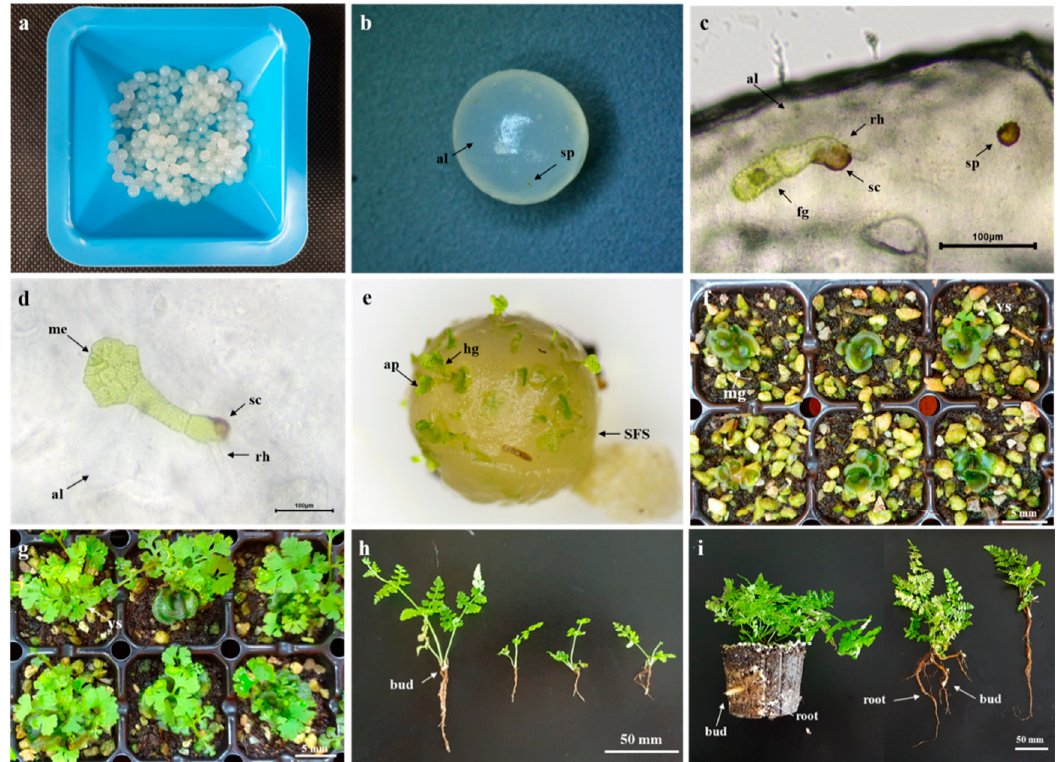
Figure 3. SFS (synthetic seeds using fern spores) production and growth cycle of bracken through spore-derived encapsulation method: ( a ) SFS produced with a 2.5 mm syringe tip; ( b ) spores inserted into the alginate matrix; ( c ) germinated spore and gametophyte after two day in SFS; ( d ), normal developing gametophyte; ( e ) heart-shaped gametophytes formed on the inside and surface of SFS; ( f ) mature gametophytes and young sporophytes developed after 4 weeks in SFS; ( g ) young sporophytes grown after 8 weeks in SFS; ( h ) root growing point observed at three weeks after transplanting; ( i ) strong root development and a large number of root growing-points were observed at eight weeks after transplanting. al, alginate matrix; ap, apical notch; bud, root growing-point; fg, filament gametophyte cell; hg, heart-shaped gametophyte; me, meristematic cell; mg, mature gametophyte; rh, rhizoid; sc, spore coat; sp, spore; ys, young sporophyte.